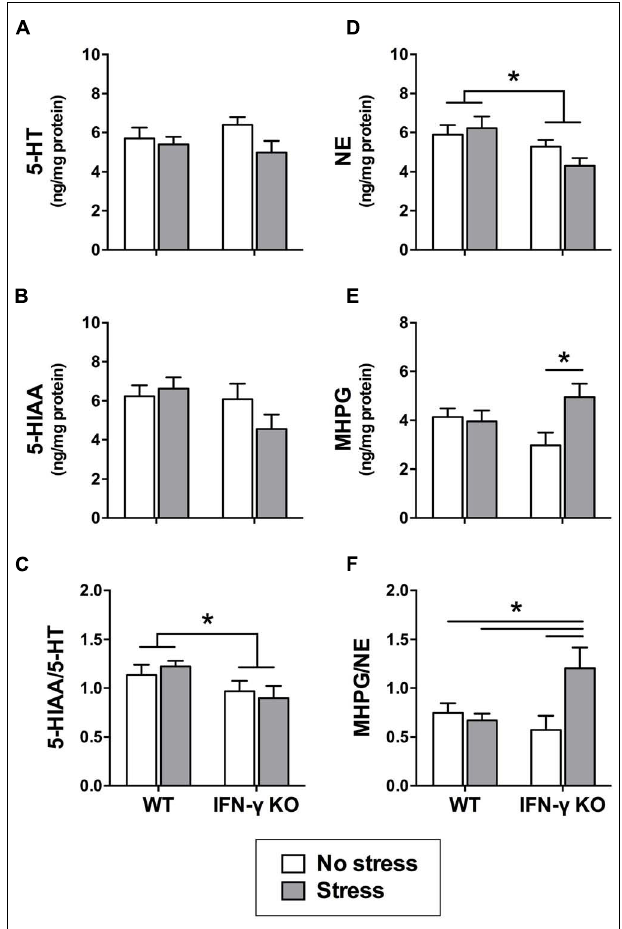
FIGURE 4 | Hippocampal serotonin and noradrenergic activity as a function of IFN- γ knockout and chronic stressor exposure. Within the hippocampus, neither 5-HT (A) nor 5-HIAA (B) was significantly affected by chronic stress or IFN- γ deletion.Yet, 5-HT turnover (i.e., the ratio of 5-HIAA to 5-HT; C) was diminished overall in the IFN- γ knockouts compared to the wild-type mice.With respect to noradrenergic neurotransmission in the hippocampus, NE levels (D) were significantly reduced among the IFN- γ knockout mice, irrespective of chronic stress. In contrast, both MHPG accumulation (E) and NE turnover (MHPG-to-NE ratio; F) were significantly enhanced following chronic stress, but only among the IFN- γ knockouts. Data are presented as mean ± SEM; * p < 0.05 (Two-way ANOVA followed by Student–Newman–Keuls test).WT, wild-type, KO, knockout.